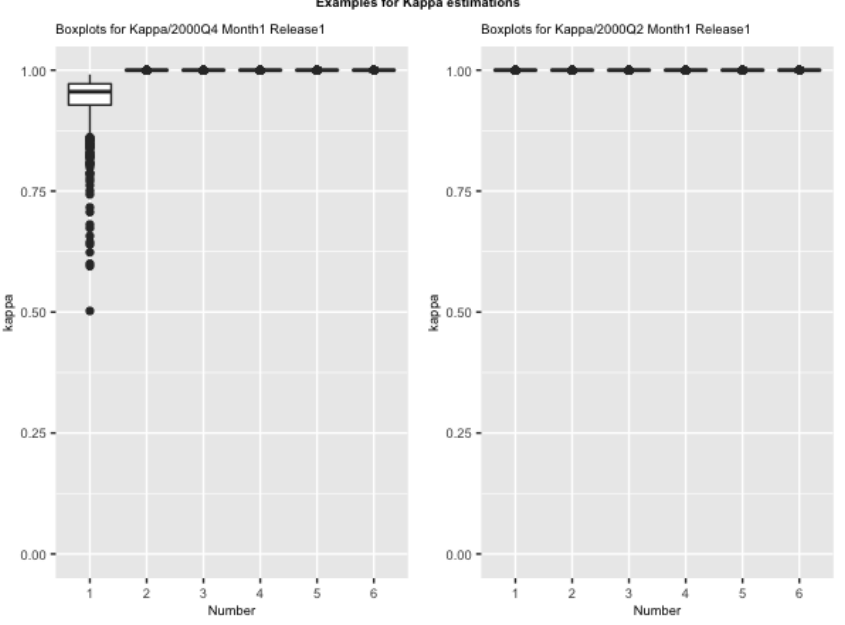
Figure 8. Two examples of boxplots for posterior draws of κ j . Left panel represents the one for nowcasting GDP of 2000Q4 in the first release of the first month. Right panel represents the one for nowcasting GDP of 2000Q2 in the first release of the first